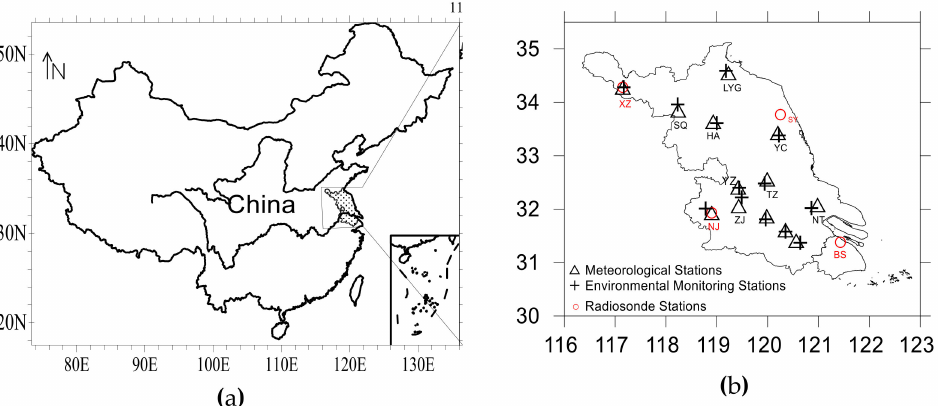
Figure1. ( a )ThegeographicallocationofJiangsuprovince, China(UTC / GMT + 08:00); ( b )Thedistribution LYG; Xuzhou: XZ; Nanjing: NJ; Nantong: NT; Suqian: SQ; Zhenjiang: ZJ; Taizhou: TZ; Huaian: HA; Yancheng: YC; Changzhou: CZ; Suzhou: SZ; Yangzhou: YZ; Baoshan: BS; Sheyang: